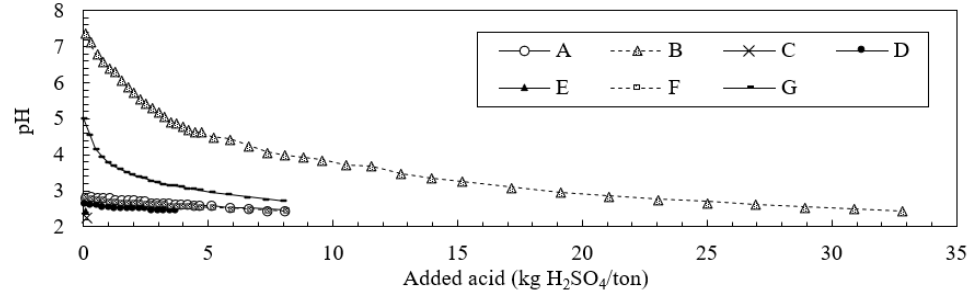
Figure 5. Changes in pH with the addition of HCl during the acid buffering characteristic curve (ABCC) test.